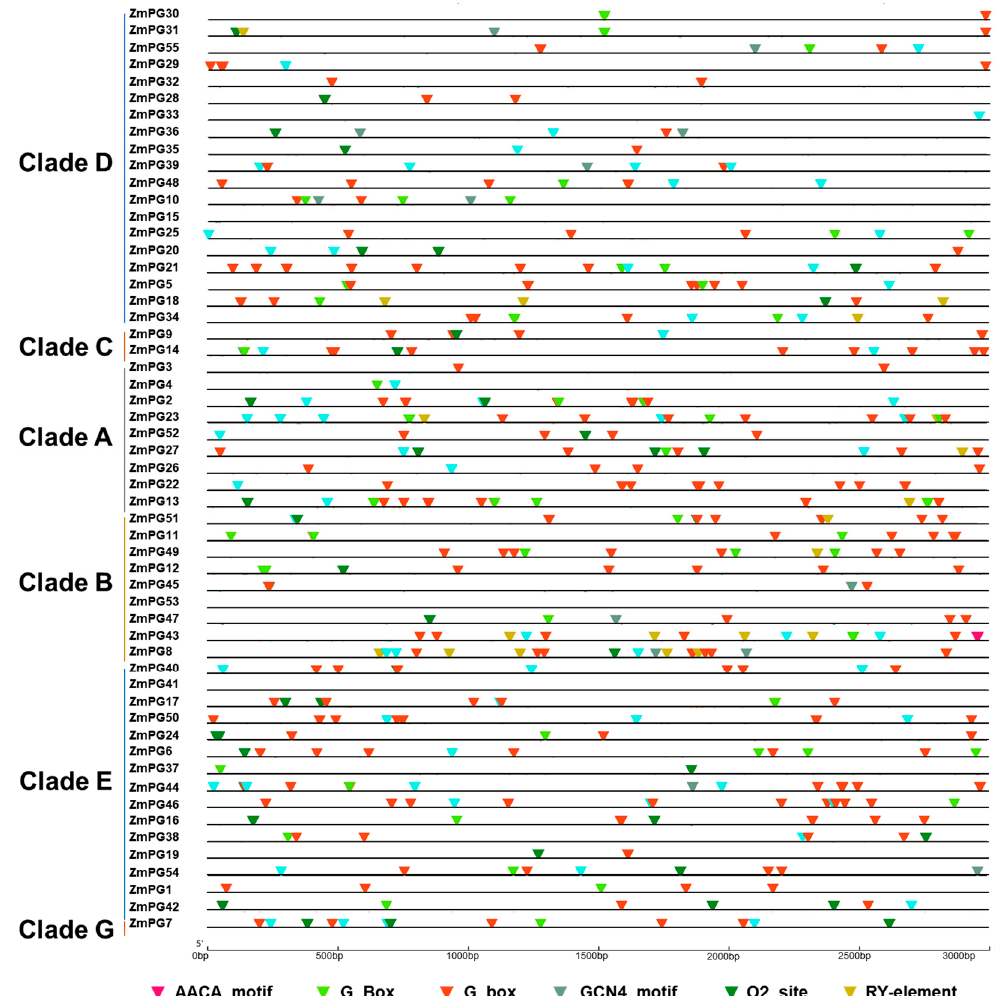
Figure 5. Schematic model of seven cis -elements in the promoter sequences of ZmPGs . AACA_motif is associated with endosperm-specific negative expression, the G-box/G-Box cis -acting regulatory element is involved in light responsiveness, GCN4_motif is involved in endosperm expression, MBS represents a MYB binding site, O2-site represents a cis -acting regulatory element, which is involved in zein metabolism and regulation, and RY-element is involved in seed-specific regulation.